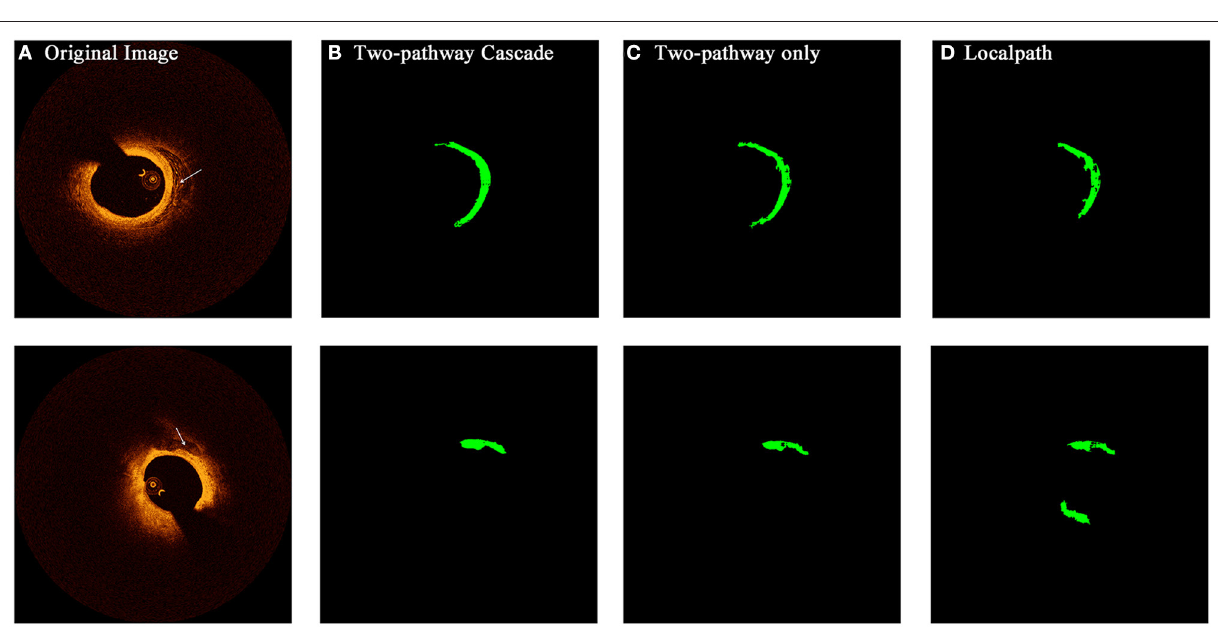
FIGURE 7 | The prediction results of OCT images with calcified composition by different types of networks. Rows (A–D) show the initial OCT image, prediction by TwoPathCNN network with cascaded structure, prediction by TwoPathCNN only, and prediction by LocalPath, respectively. The characterized calcific composition is marked in